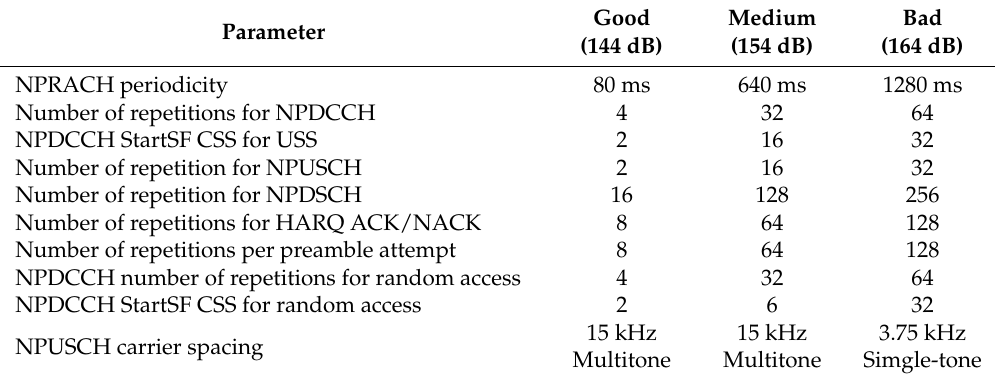
Table 3. Parameters for Each Channel Quality According to MCL.